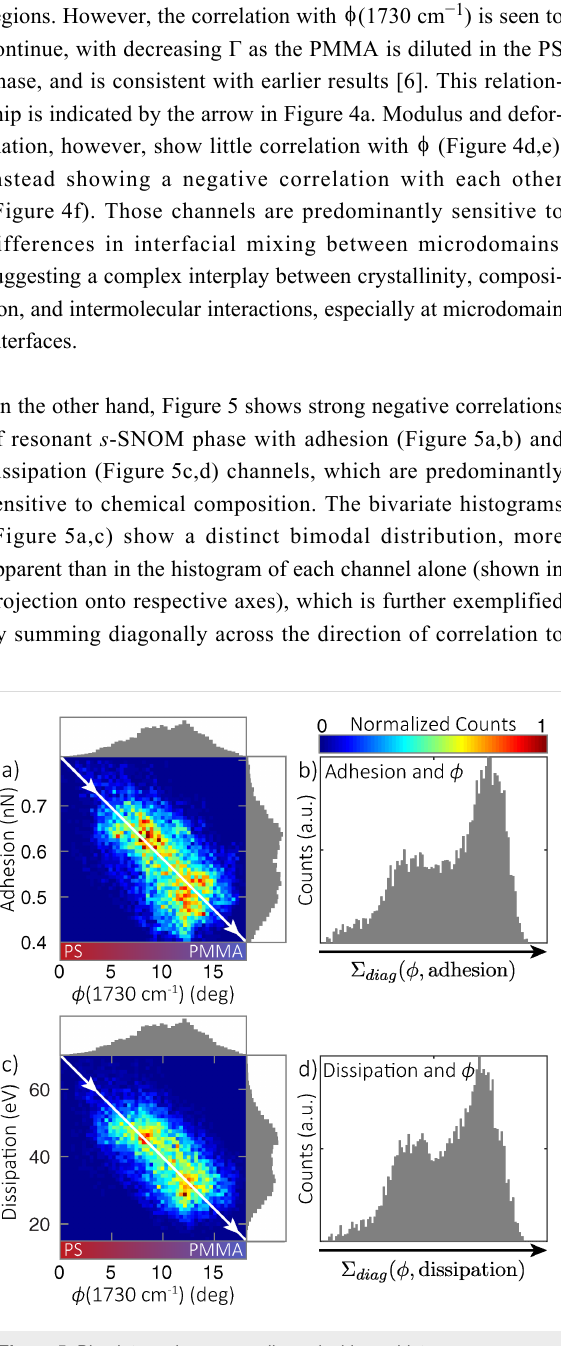
Figure 5d. The two populations in this distribution